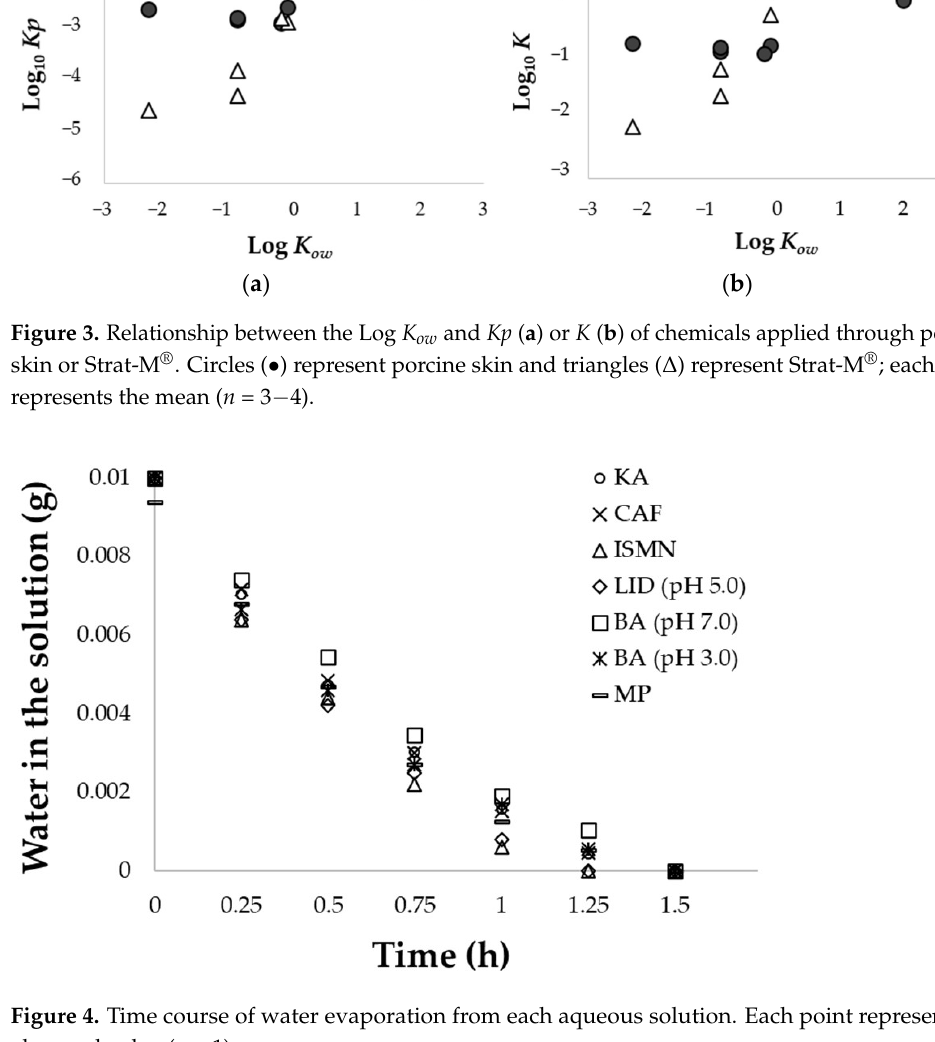
Figure 5. Comparison of predicted versus observed values using porcine skin for percutaneous ab- sorption ratio. Each point represents the mean, while the dashed line corresponds to a factor 2. The Pearson’s correlation coefficient showed statistical significance (* p < 0.05). 3.5. Prediction of Percutaneous Absorption Using Strat-M ® As described in Section 3.2, the permeation of hydrophilic chemicals (KA, LID (pH 5.0) and BA (pH 7.0)) was significantly decreased in Strat-M ® compared to porcine skin. Therefore, with respect to four chemicals (CAF, ISMN, BA (pH 3.0), and MP), the param- eters obtained using Strat-M ® were applied to our mathematical model and percutaneous absorption under finite dose conditions was estimated. Figure 6 shows the relationship between predicted values and observed values using porcine skin in finite dose experi- ments. The almost 1:1 relationship (slope ≈ 1.0) and the very high correlation coefficient (0.993, p < 0.05), between these values, were obtained among four chemicals.